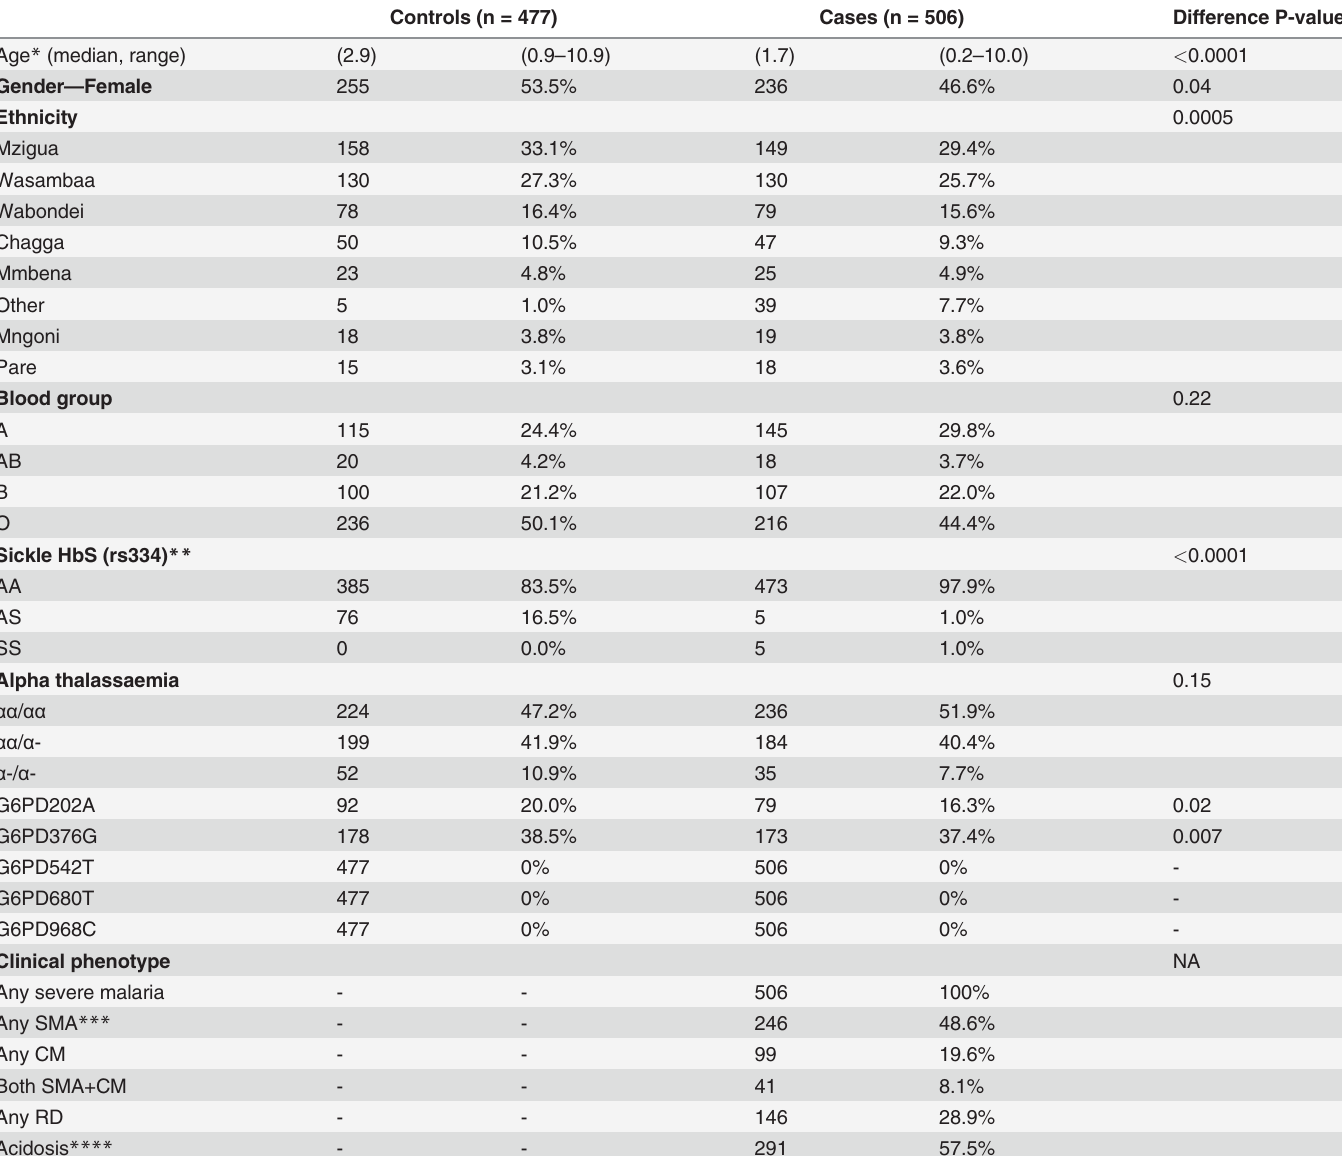
Table 1. Baseline and clinical